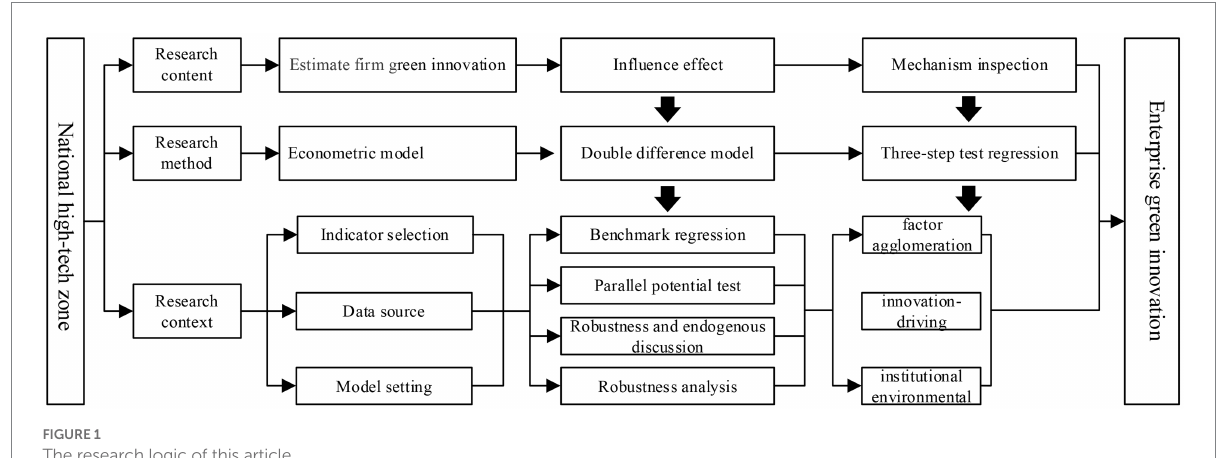
FIGURE 1 The research logic of this